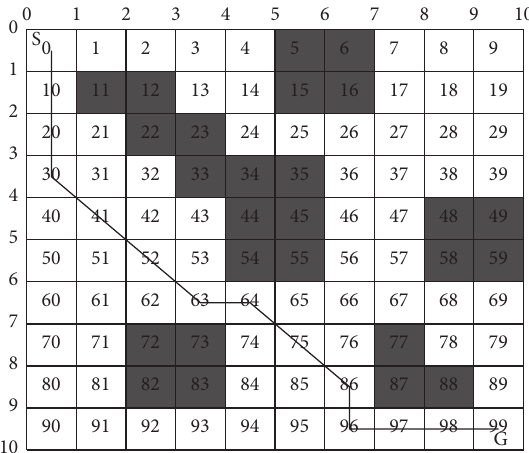
Figure 4: Path diagram after reducing the break points.